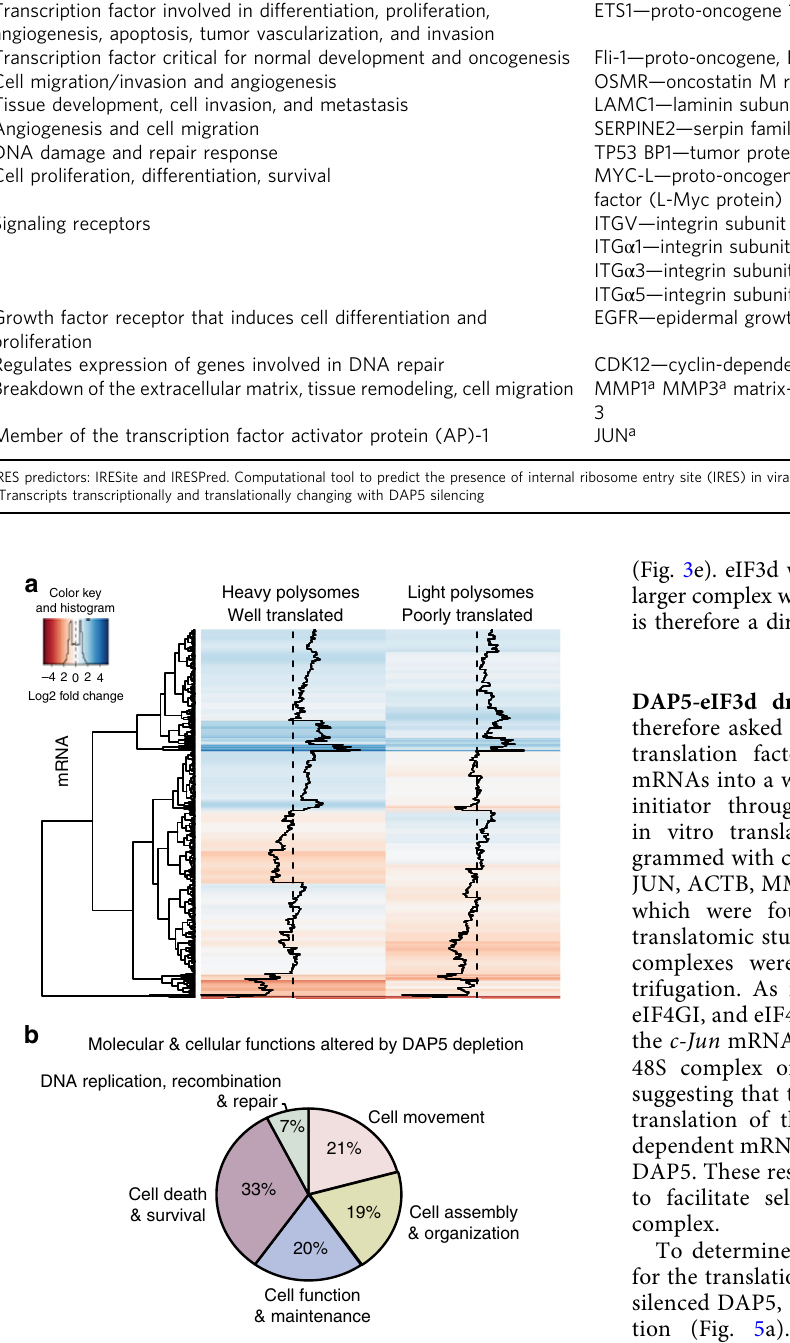
Table 1 mRNAs most strongly reduced in polysomes with DAP5 silencing